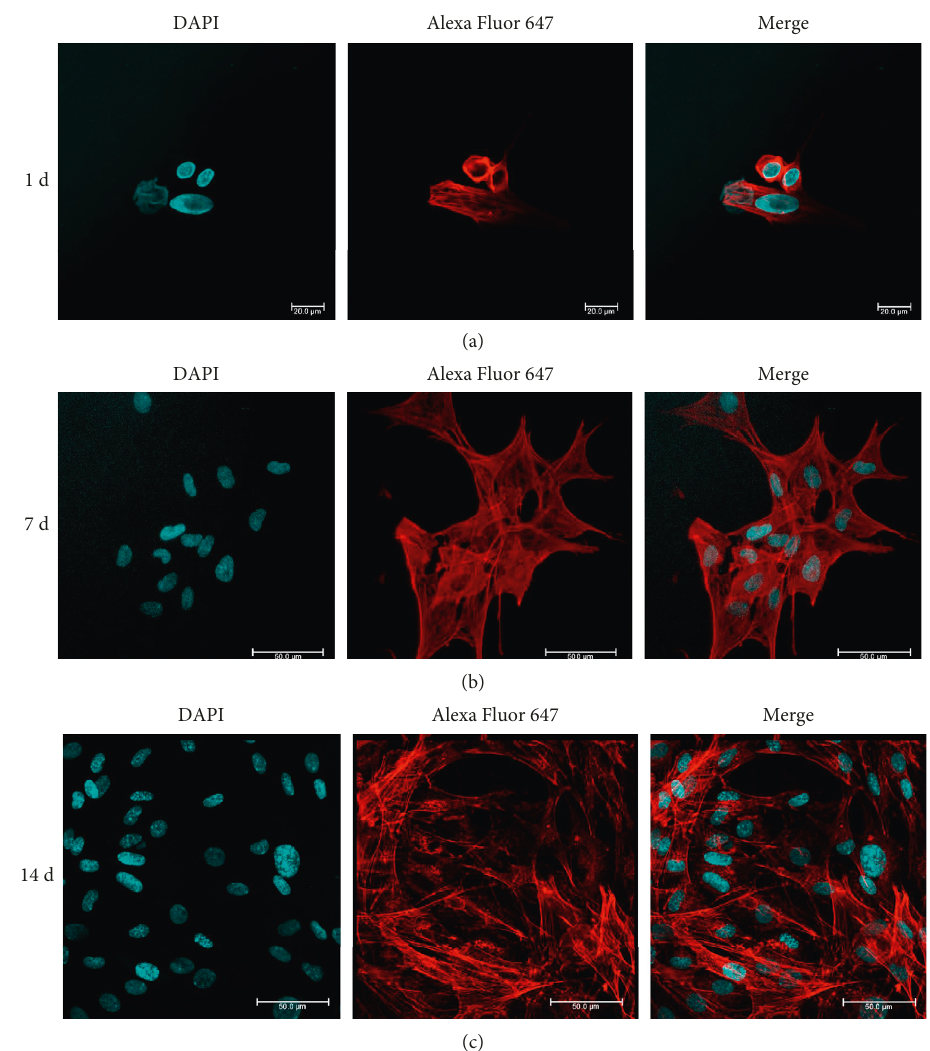
Figure 8: Confocal microscopy analysis of ASC cells adhered to HAC-EDTA at culture times of 1, 7, and 14 days. (a) Cells with low concentration of Ca 2+ and Mg 2+ on the first day of culture, which represents difficulty in adhesion of cells to the surface of the material. (b) Adhesion was higher when Ca 2+ and Mg 2+ were added to the material, presenting a larger number of cells on 7th day of culture. (c) After 14 days, the cells increased in quantity and continued to have morphology of the cell